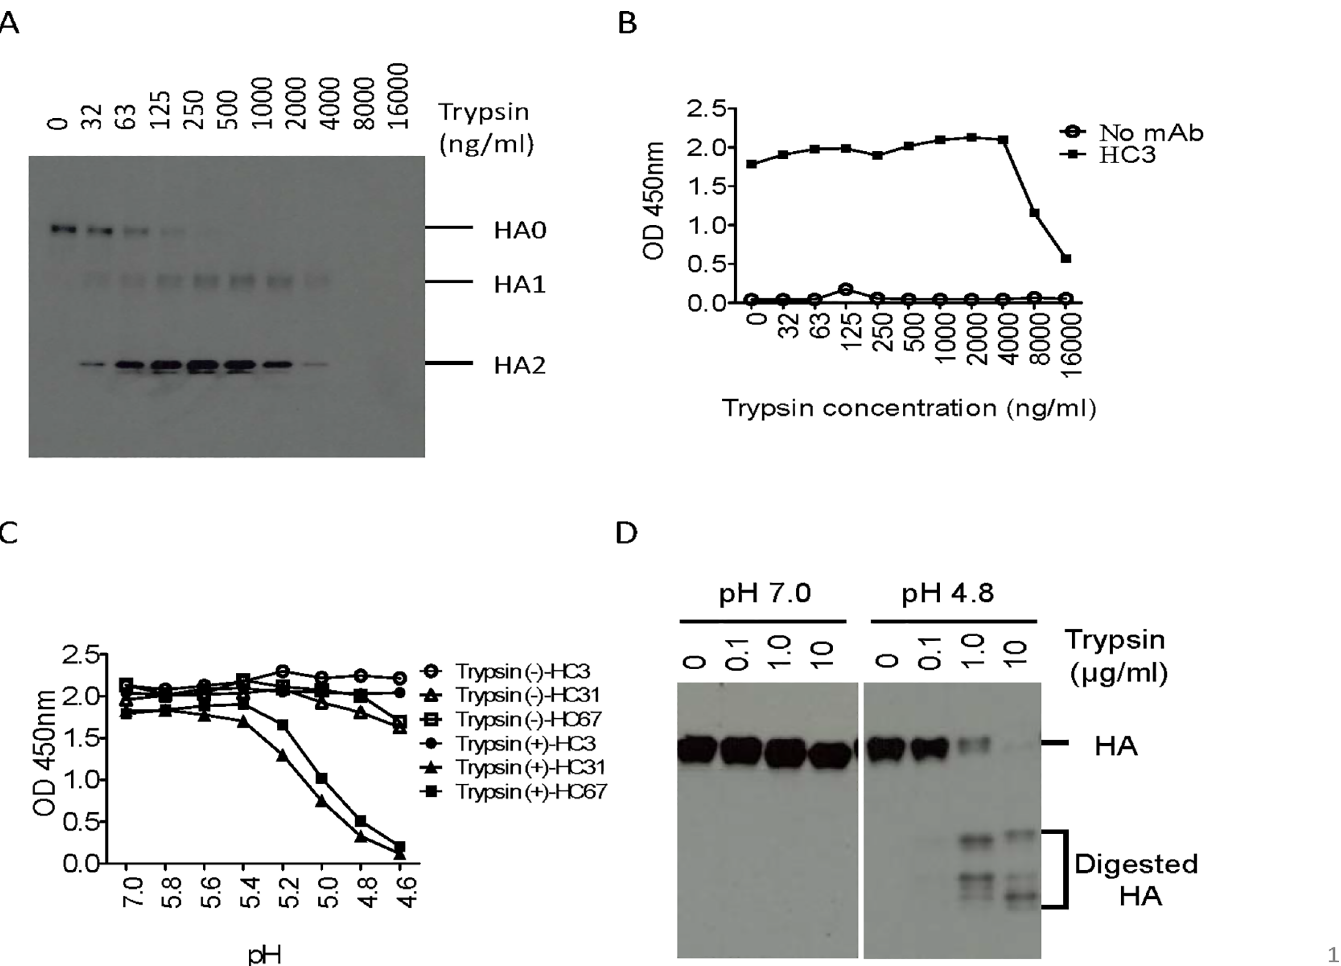
Fig 2. Determination of low pH induced conformational change of H3 rHA on 96-well nickel-coated plate. Optimization of trypsin concentration for cleavage of rHA coated on nickel-coated plates. H3 rHA bound nickel-coated plates were digested with two-fold serially diluted trypsin starting from 16,000 ng/ml to 32 ng/ml in PBS and PBS only as control. A. rHAs were eluted by 1X reducing SLB supplemented with 0.5M Imidazole followed by Western blot using anti H3 rabbit sera. B. Trypsin treated rHAs were analyzed by ELISA using anti H3 monoclonal antibody HC3. C. Cleavage of HA0 into HA1 and HA2 of H3 rHA by trypsin was essential for low pH induced HA conformational changes. H3 rHAs bound to nickel-coated plates were treated with 100 μ l of 200 ng/ml trypsin to cleave HA0 into HA1 and HA2. The plate was treated with a series of pH buffers followed by fixation with 0.05% glutaraldehyde in PBS. ELISA was performed by using pH-specific mAbs HC31 and HC67, and HC3 served as a control for H3 rHA. D. The proteinase susceptibility assay was performed to confirm the low pH induced HA conformational changes in Fig 2D. The H3 rHA bound nickel-coated plate was treated with pH 7.0 or pH 4.8 followed by 0, 0.1, 1, or 10 μ g/ml trypsin digestion. Total sample which included the digestion mixture and rHA remaining bound to the plate were entirely eluted from the nickel-coated plate by adding an equal volume of 2X non-reducing SLB supplemented with 1M imidazole and were separated by SDS-PAGE under non-reducing conditions. PAGE-separated proteins were transferred to a nitrocellulose membrane and probed with a rabbit anti A/Aichi/1/68 (H3N2) antisera. HA proteins were detected by chemiluminescence with an HRP-conjugated secondary antibody.